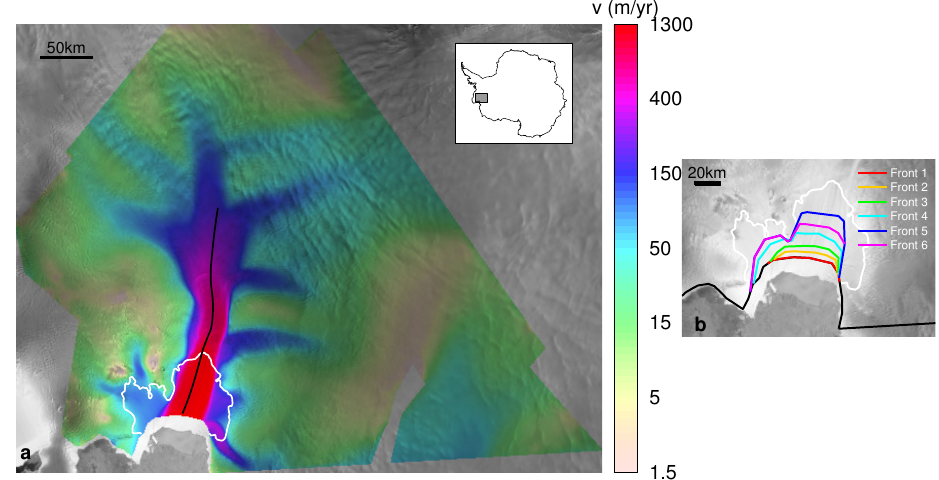
Figure 1. (a) Initial modeled 2008 velocity of Pine Island Glacier, overlain on a MODIS Mosaic of Antarctica with initial grounding line position (white) and glacier centerline (black). (b) Ice front positions used in the sensitivity study.